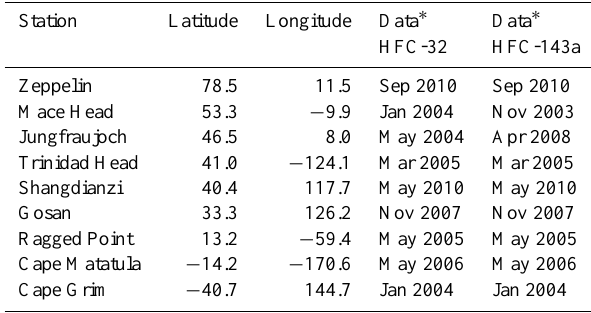
Table 1. Overview of AGAGE measurement stations, their coordi- nates and periods for which data are